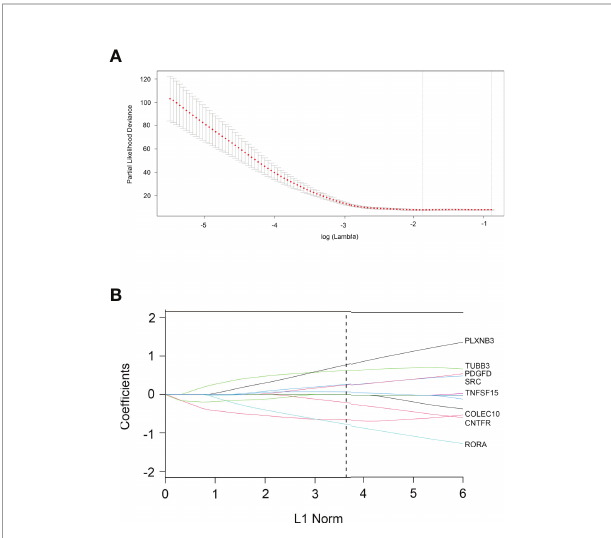
FIGURE 2 | Construction of an 8-IRDEGs signature from the TCGA cohort. (A) Tenfold cross-validation for tuning parameter selection in the LASSO model. The dotted vertical lines are drawn at the optimal values by minimum criteria (lambda. min, left vertical dotted line) and 1-SE criteria (lambda.1se, right vertical dotted line). (B) LASSO model at optimal lambda value; 8 mRNAs with non-zero coef fi cients were